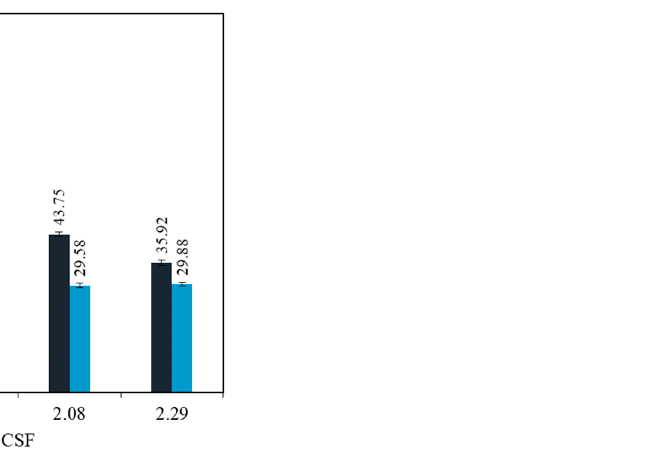
Figure 3. Furfural production from xylose in the first hydrolysate and synthetic medium, depending on CSF.